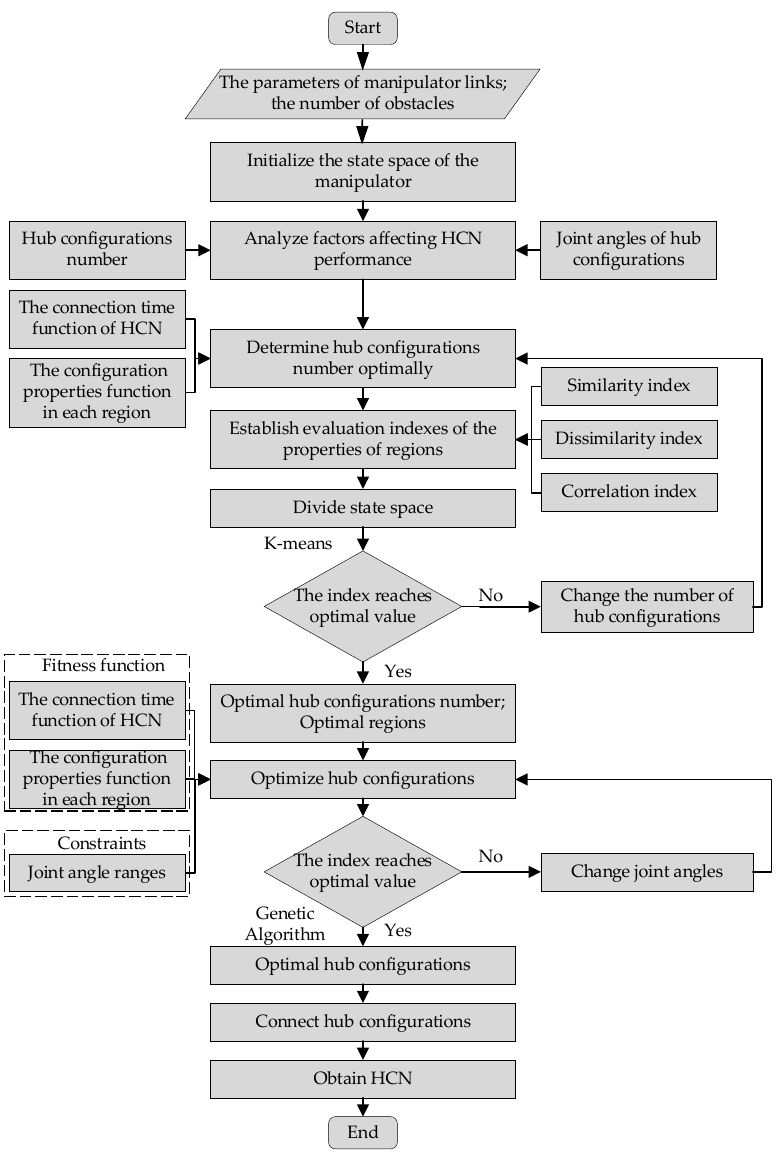
Figure 4. Process of HCN construction.